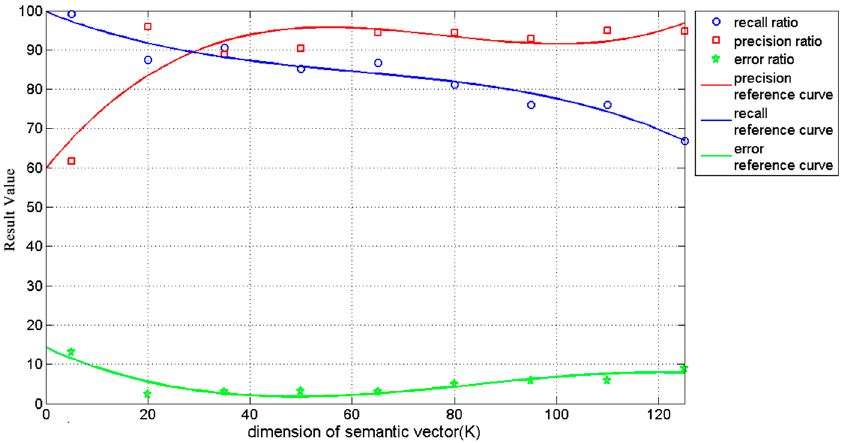
Figure 15. Effects of parameter K for cloud detection.